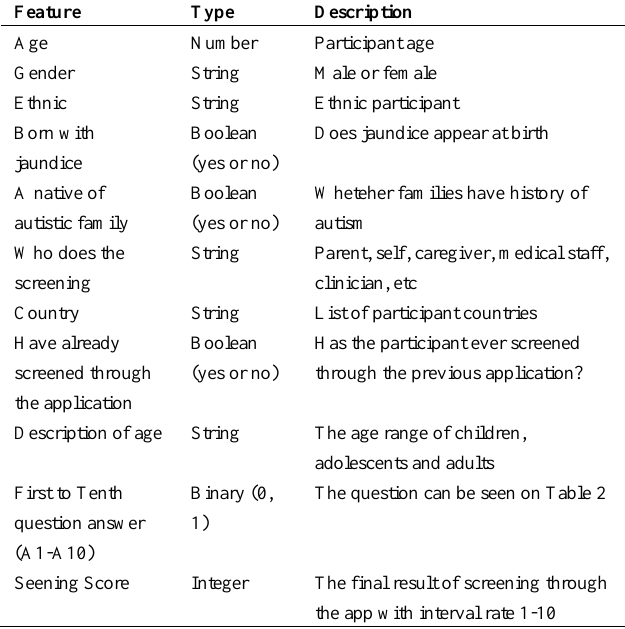
Table 1. AQ-Screening Dataset